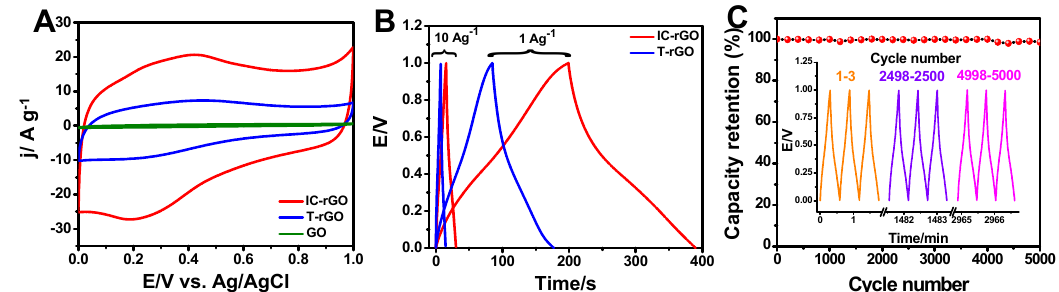
Figure 5. ( A ) Cyclic voltammogram with a 0.1 V s − 1 scan rate on GO, T-rGO, and IC-rGO-modified glassy carbon electrode (GCE). ( B ) Constant current charge/discharge curves of T-rGO and IC-rGO. ( C ) Cyclic stability of IC-rGO at 10 A g − 1 ; the insert shows the charge discharge curves at different stages of the cycle life testing. (All experiments were performed in a three-electrode cell in 0.5 M H 2 SO 4 ). (adapted from ref. [78], with permission from Royal Society of Chemistry 2017).